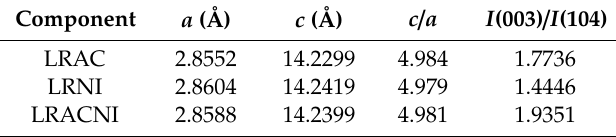
Table 2. Lattice parameters of LRAC, LRNI, and LRACNI samples.